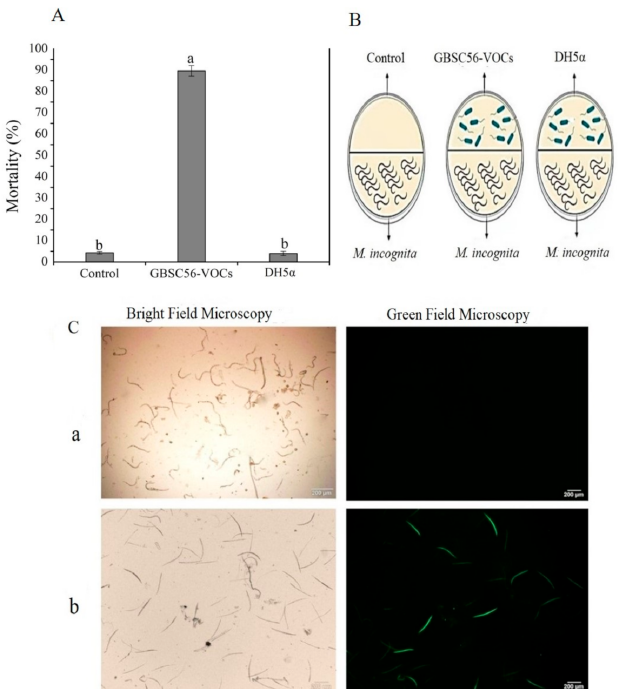
Figure 1. Nematicidal activity of GBSC56-VOCs compared with control and DH5 α . ( A ) Graphical detail of nematicidal activity of GBSC56-VOCs. ( B ) Partition plate assay to find the nematicidal activity of GBSC56. ( C ) ROS induction in nematodes pre-exposed to GBSC56-VOCs ( b ) caused severe oxidative damage as compared with control ( a ). Error bar represents the mean standard deviation of each treatment repeated three times with three replicates. The small letters above the columns indicate significant difference. The significant difference among the treatments was calculated through the Tukey HSD test at p ≤